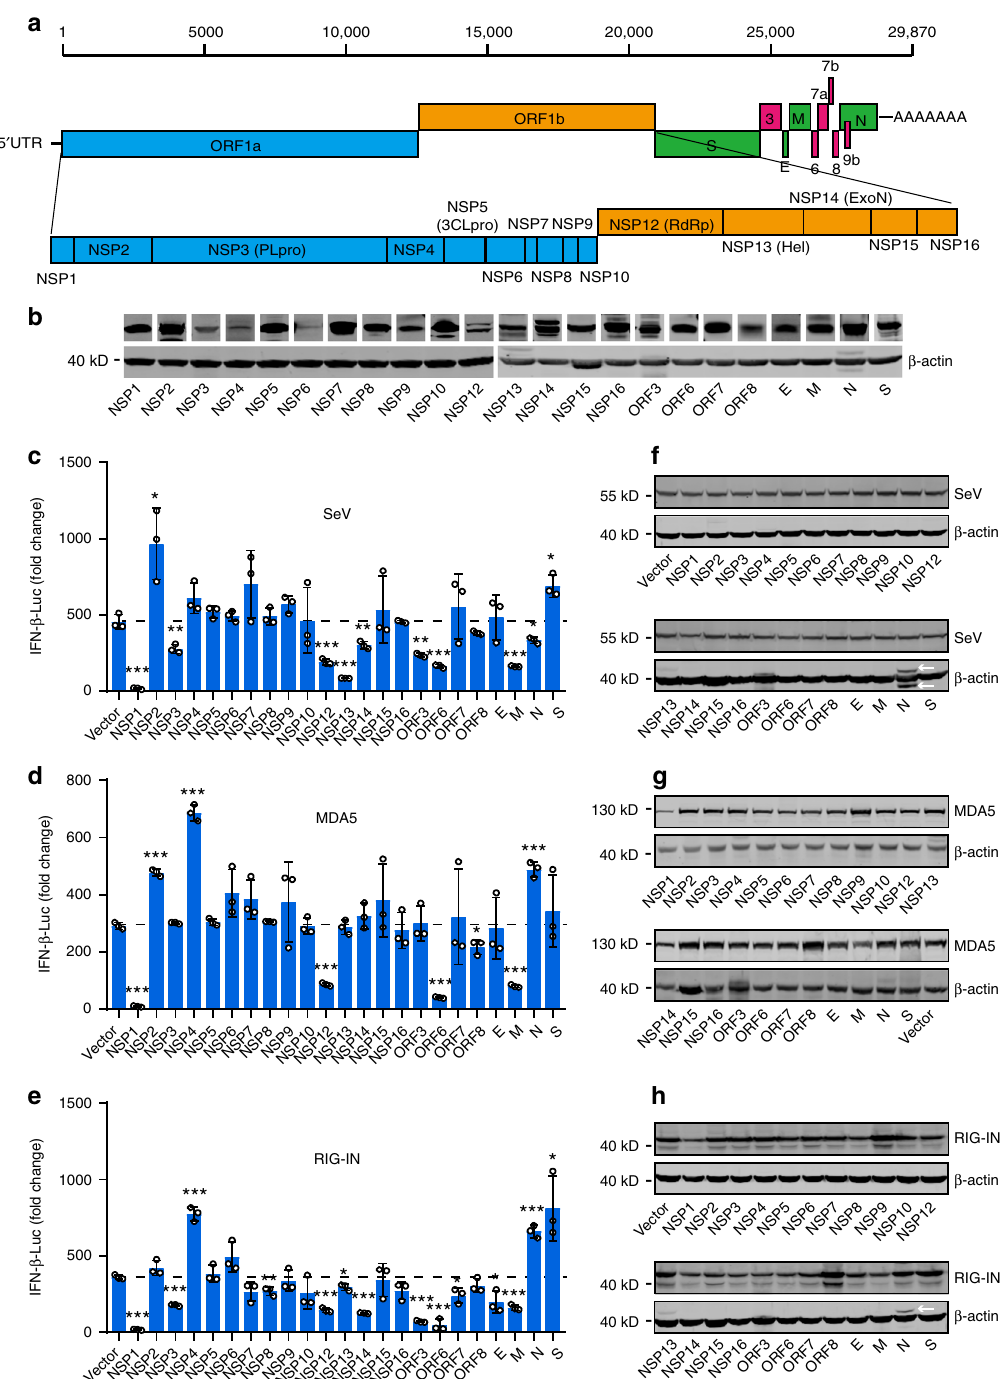
Fig. 2 Identi fi cation of viral proteins perturbing IFN- β production. a Schematic diagrams of the SARS-CoV-2 genome. The genome includes 5 ′ UTR- ORF1a-ORF1b-S-ORF3-E-M-ORF6-ORF7 (7a and 7b)-ORF8-N-3 ′ UTR in order. Fifteen nonstructural proteins, four structural proteins, and four accessory proteins were delineated. b Protein expressions of SARS-CoV-2 genes. HEK293T cells were transfected with 500 ng plasmid in 24-well plates. Protein expressions were detected by Western blot. β -actin was used as a loading control. c Effect of SARS-CoV-2 proteins on SeV-induced IFN- β promoter activation. HEK293T cells were transfected with an IFN- β reporter plasmid, along with a control plasmid or with plasmids expressing the indicated SARS- CoV-2 proteins. At 24 h post-transfection, cells were infected with SeV for 12 h, and luciferase activity was measured. d , e Effects of SARS-CoV-2 proteins on RIG-IN and MDA5-induced IFN- β promoter activation. HEK293T cells were transfected with IFN- β promoter plasmid, along with a control plasmid or with plasmids expressing the indicated SARS-CoV-2 proteins, together with a plasmid expressing RIG-IN d or MDA5 e . At 24 h post-transfection, cells were harvested and luciferase activity was measured. f – h Expressions levels of SARS-CoV-2 protein, RIG-IN, and MDA5. Lysates of cells from c – e were subjected to Western blot analysis. Arrows indicate remnants of blots for SARS-CoV-2 proteins. All experiments were done at least twice, and one representative is shown. Error bars indicate SD of technical triplicates. * P < 0.05, ** P < 0.01, and *** P < 0.001, two-tailed Student ’ s t -test. Source data are provided as a Source Data fi